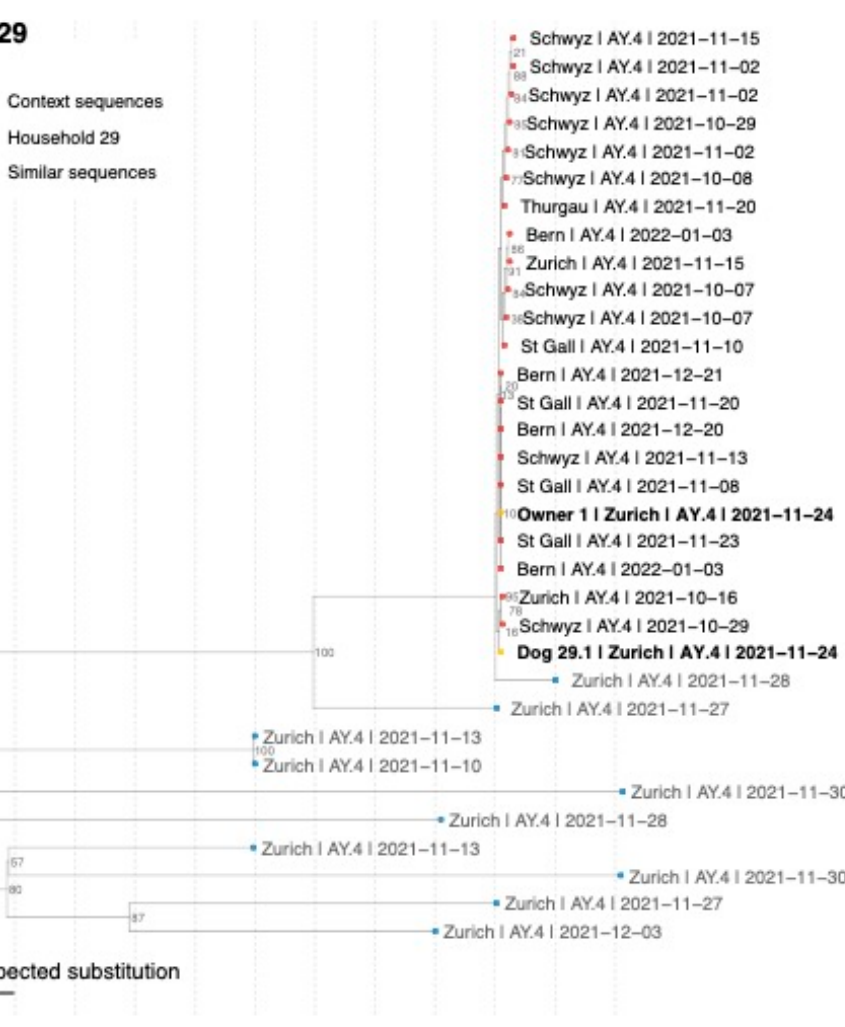
Figure A3. Maximum-likelihood phylogenetic tree showing the relationship between the two se- quences of USZ29 (yellow dots and bold text) and their respective 10 most genetically similar Swiss sequences obtained from GISAID. The most similar sequences (red dots) are defined as those with the smaller number of SNPs differences to each household sequence (sequences that are part of the 10 closest sequences for several of the household sequences only appear once in the tree). Blue dots indicate a representative set of 10 sequences circulating in Zurich in November–December 2021 from pangolin lineage AY.4 (context sequences). Location, pangolin lineage, and collection date are shown for each sequence. Bootstrap values for the internal nodes are shown next to each node from 10,000 bootstrap replicates.